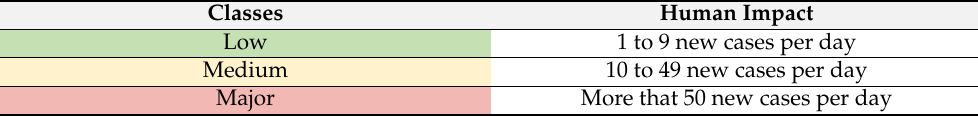
Table 10. Classification of the human impact of SARS-CoV-2 based on new cases detection.